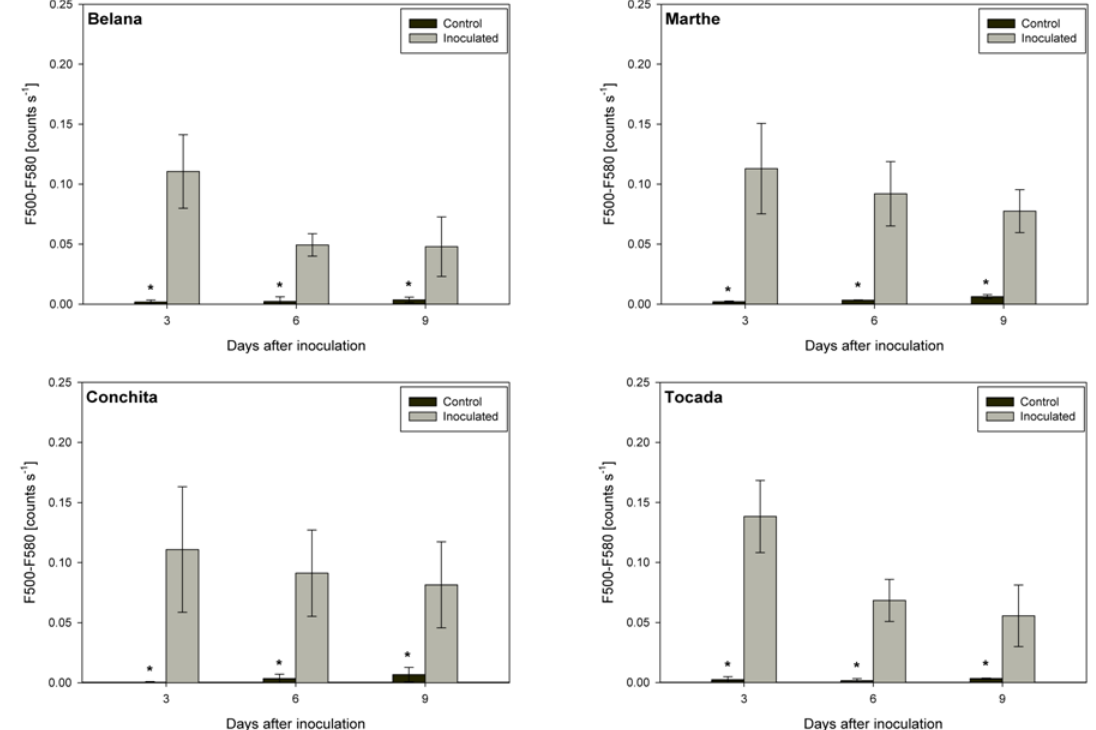
Figure 3. Green fluorescence intensity (500–580 nm scaled as counts s −1 ) recorded under blue excitation. Leaves of the healthy control and powdery mildewed plants of the barley varieties Belana, Marthe, Conchita and Tocada were studied at 3, 6, 9 days after inoculation. Values indicate mean ± standard error ( n = 5). Asterisk (*) indicate significant differences ( t -test, p ≤ 0.05) between control and inoculated leaves for each variety and measuring